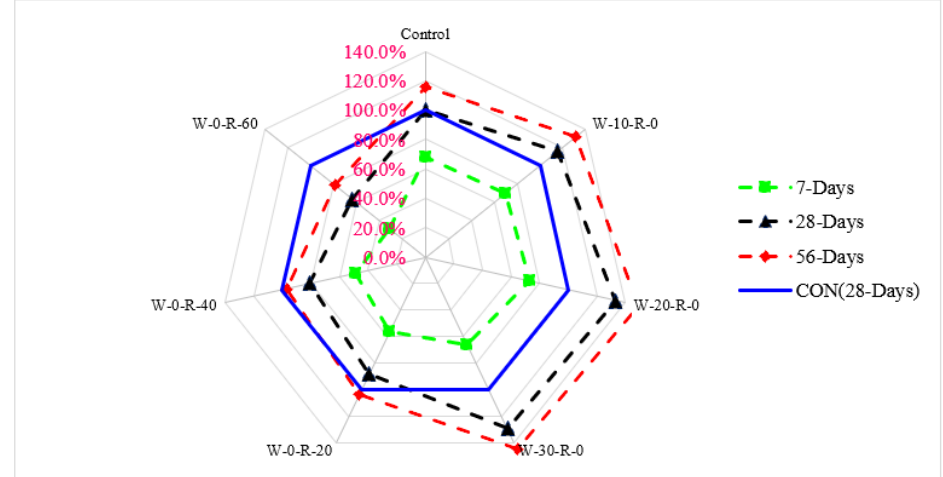
Figure 10. Relative split tensile strength.